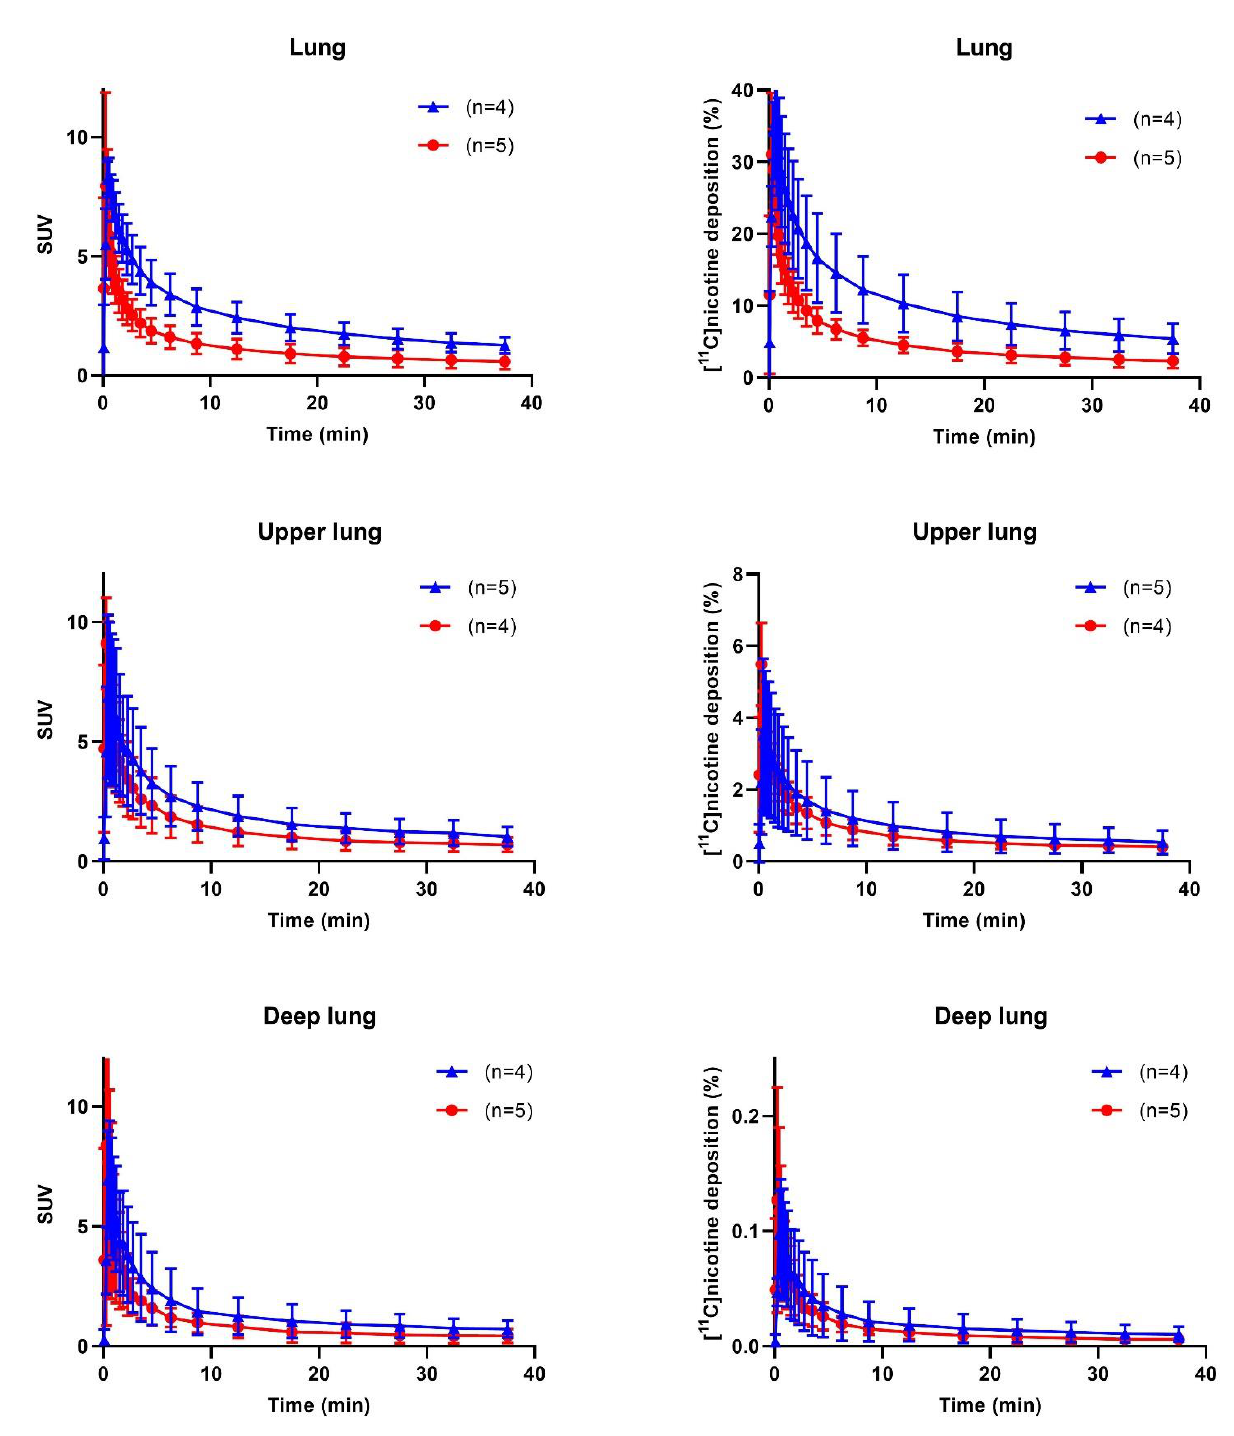
Figure 4. Mean ± SD of time activity for all regions, [ 11 C]nicotine freebase blue plots (triangles), and [ 11 C]nicotine lactate red plots (circles). Number of samples (n = 4−5) as specified in each graph.